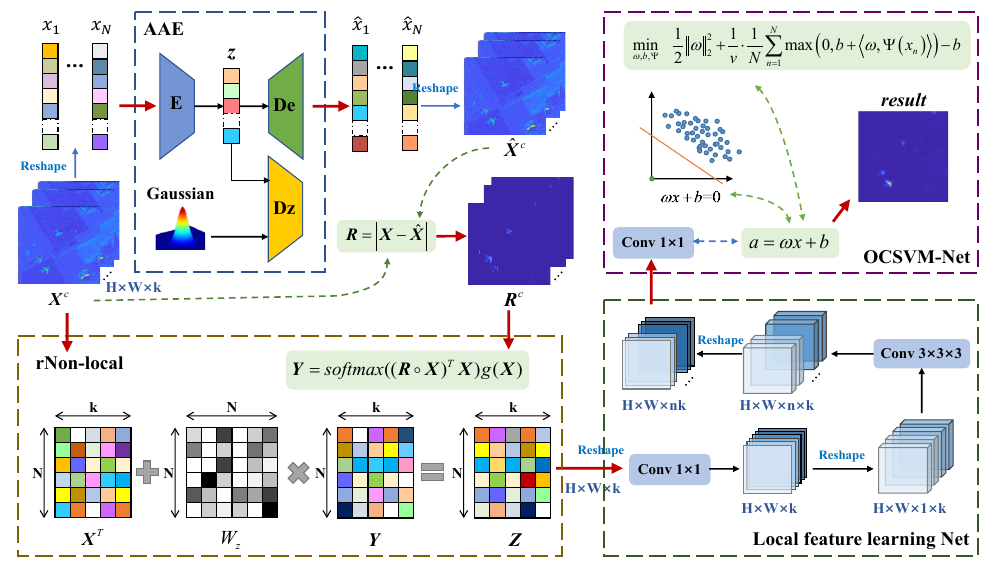
Figure 1. Flow chart of proposed method for hyperspectral anomaly detection consisting of two parts: the feature extraction network, which includes AAE, rNon-local, and Local feature learning Net, and the anomaly detection network as OCSVM-Net. X c is the original 3D hyperspectral matrix reshaped with N = H × W pixels and k bands. Here, superscript c only serves as a symbol to represent the 3D matrix with no practical meaning. Same applies to reconstructed image ˆ X c and residual image R c